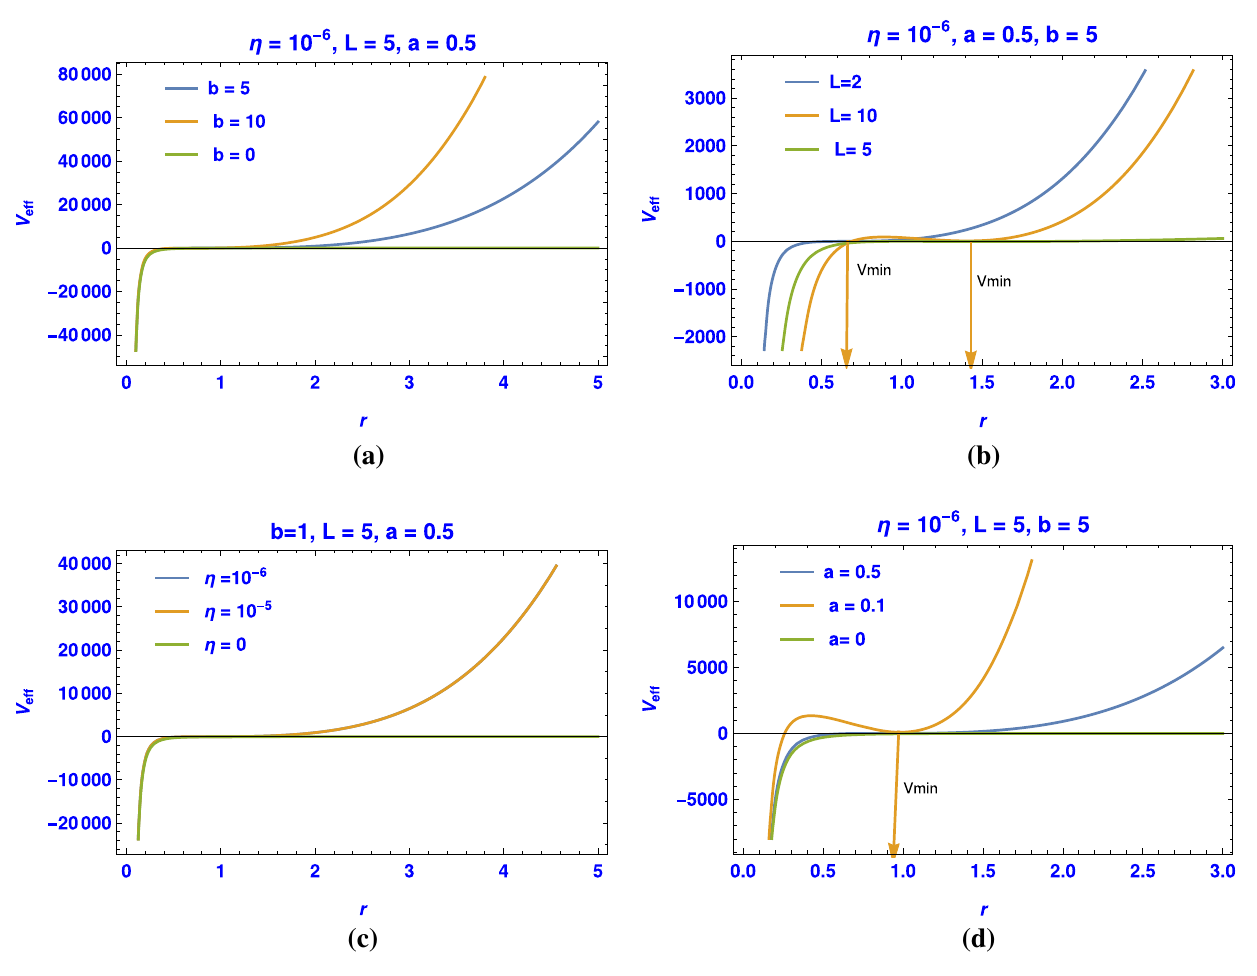
Fig. 5 This figure represents the behavior of effective potential V eff against different parameters of the BH. The local minimum value V min of the V eff corresponds to the ISCO position of the particle. a Shows that V eff is large for greater value of magnetic field; which indicates